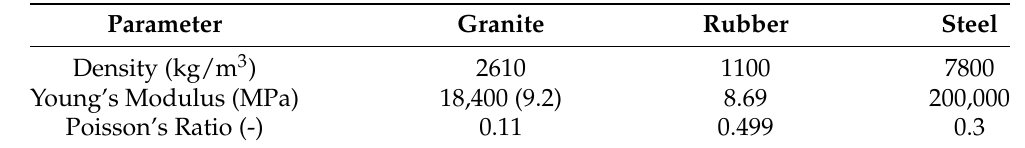
Table 2. Material parameters.